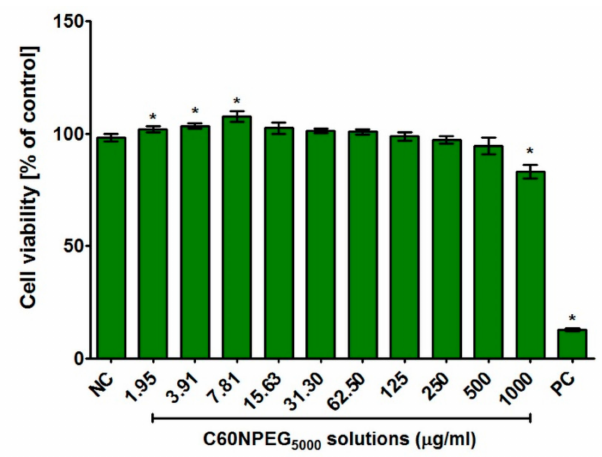
Figure 6. Human osteoblast viability (hFOB 1.19 cell line, ATCC CRL-11372 TM ) after 48-h incubation with C60NPEG 5000 solutions. Culture medium without C60NPEG 5000 was used as a negative control of cytotoxicity (NC), while 3% solution of DMSO was used as a positive control one (PC). The results were obtained using MTT assay. (* significantly different results compared to culture medium without C60NPEG 5000 -NC; unpaired t -test, p <